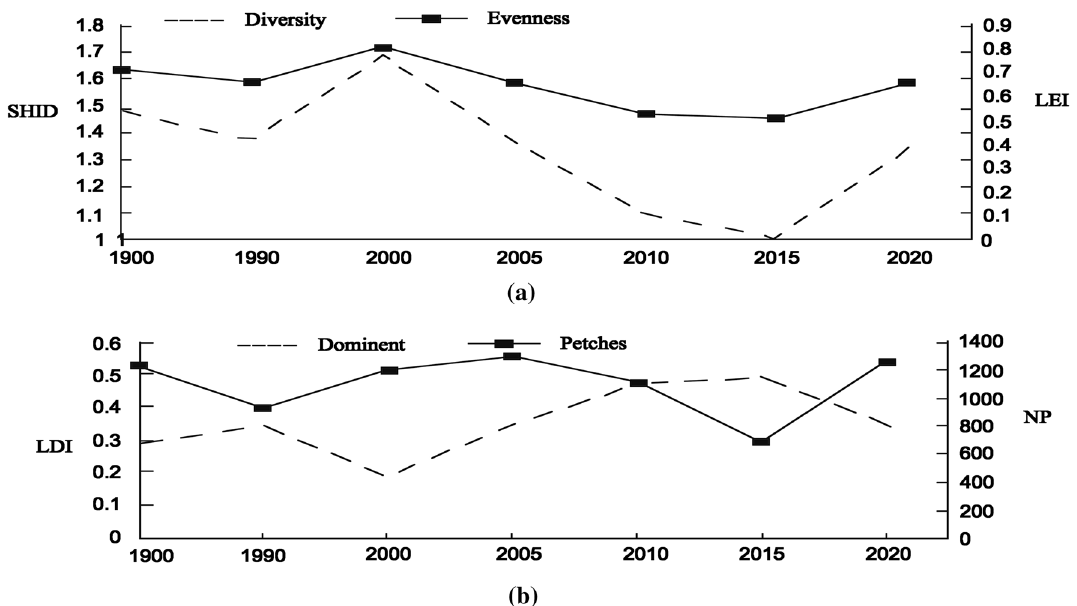
Fig. 2 Variation of wetland landscape indices from 1980 to